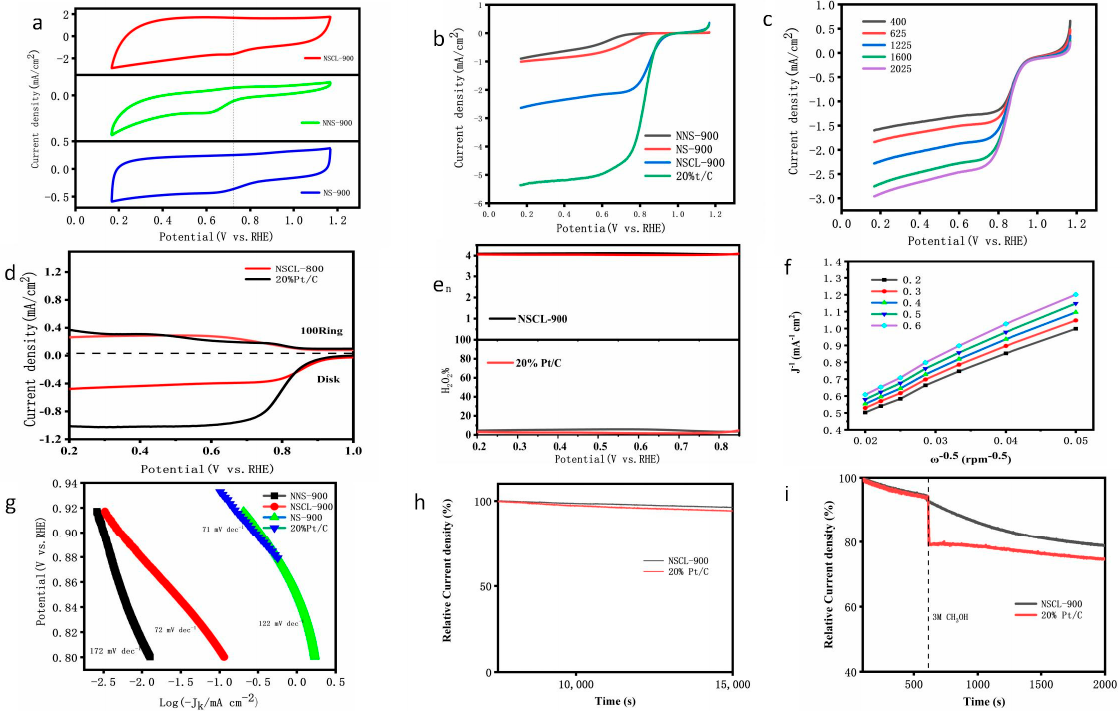
Figure 5. CV curves of NSCL-900, NNS-900, and NS-900 in 0.1 M KOH solution in a saturated atmosphere at room temperature and a scanning rate of 50 mV/s ( a ). LSV curve of NSCL-900 at electrode rotation rate of 1600 rpm and scanning rate of 10 mV/s ( b ). LSV curves of NSCL-900 at different speeds of 400-2025 RPM ( c ) correspond to K–L diagrams ( f ) of NSCL-900 at 0.2 V to 0.6 V, respectively. RRDE linear sweep voltammetry ( d ) of NSCL-900 and 20%Pt/C in a saturated 0.1 M KOH solution at a motor rotation rate of 1600 rmp and a sweep rate of 5 mV/s. The electron transfer number n (up ( e )) and yield (down E) were calculated from the RRDE measurements of NSCL-900 and 20%Pt/C. General Tafel slope curve ( g ). Stability curves ( h ) for 15,000 s of NSCL-900 and 20%P t /C in a saturated 0.1 M KOH solution at the electrode rotation rate of 1600 rmp, and toxicity curves ( i ) for methanol resistance determined by time-amperometric rule.